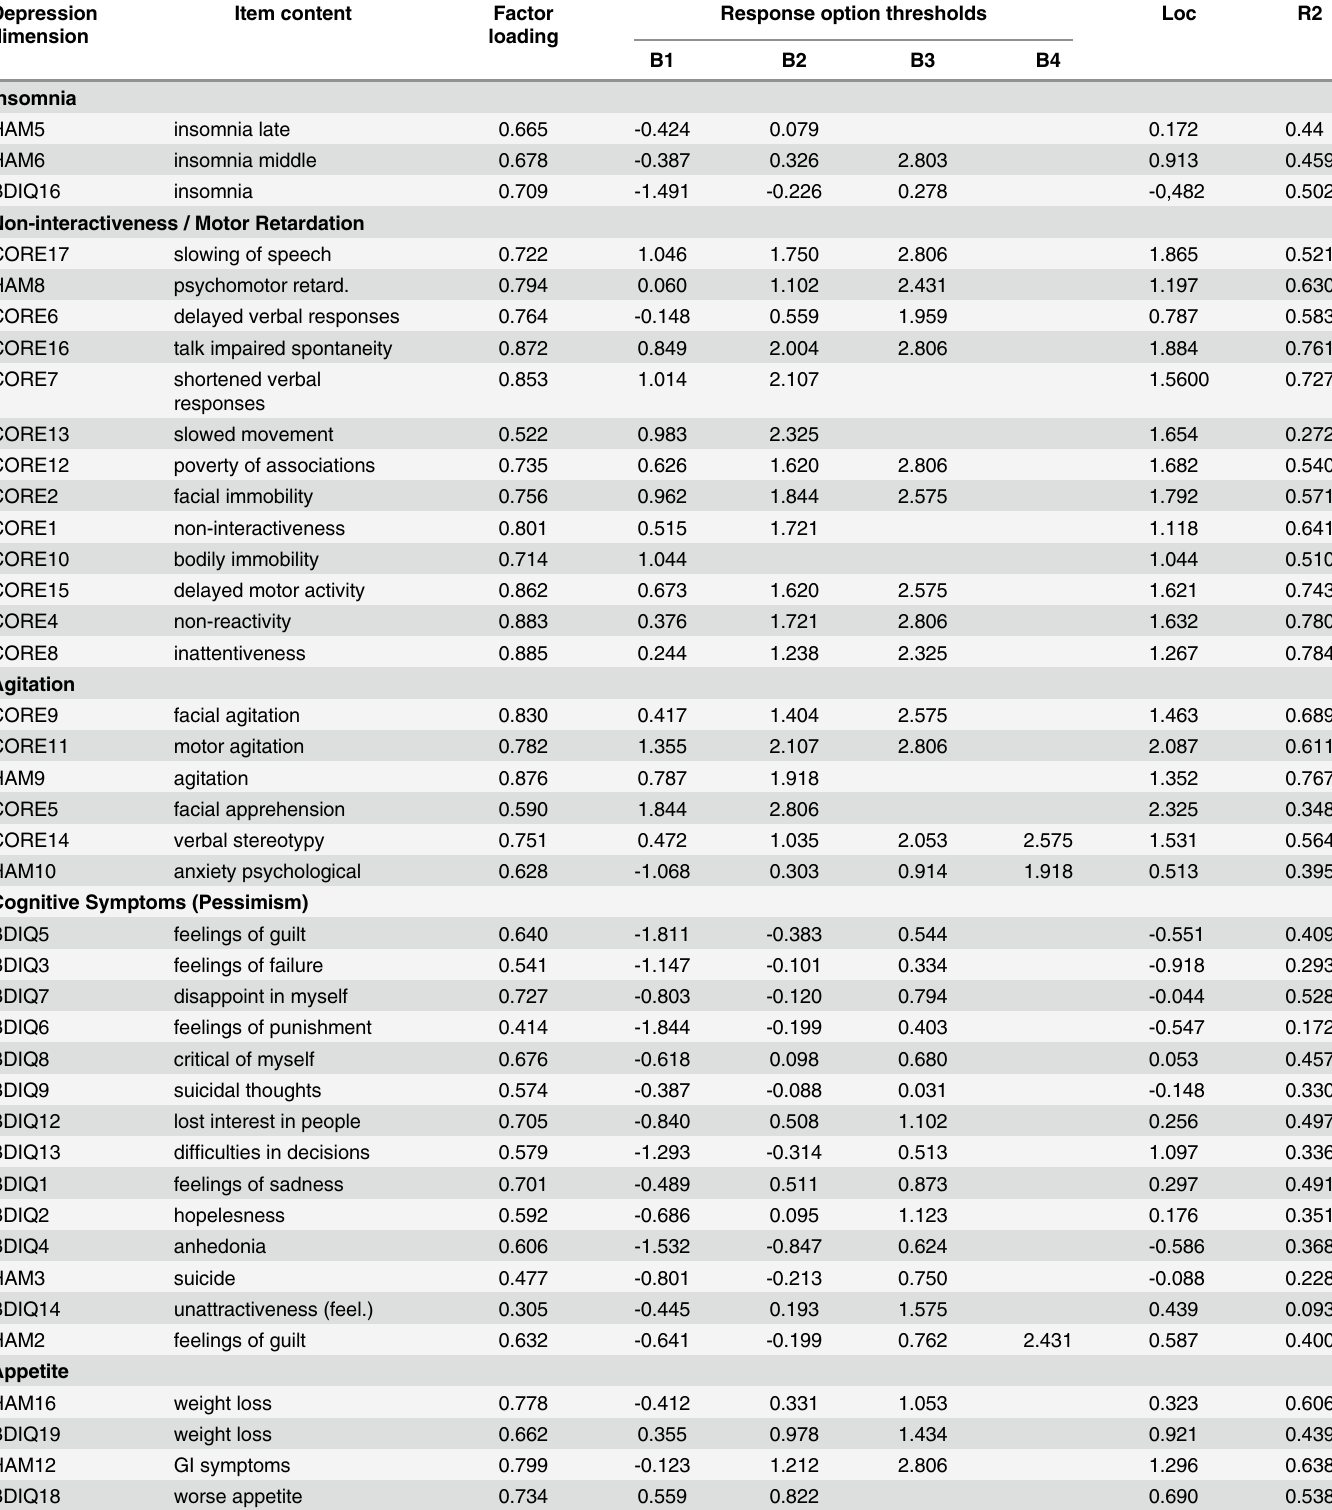
Table 3. Confirmatory Factor Analysis with factor loadings and response option thresholds. Depression